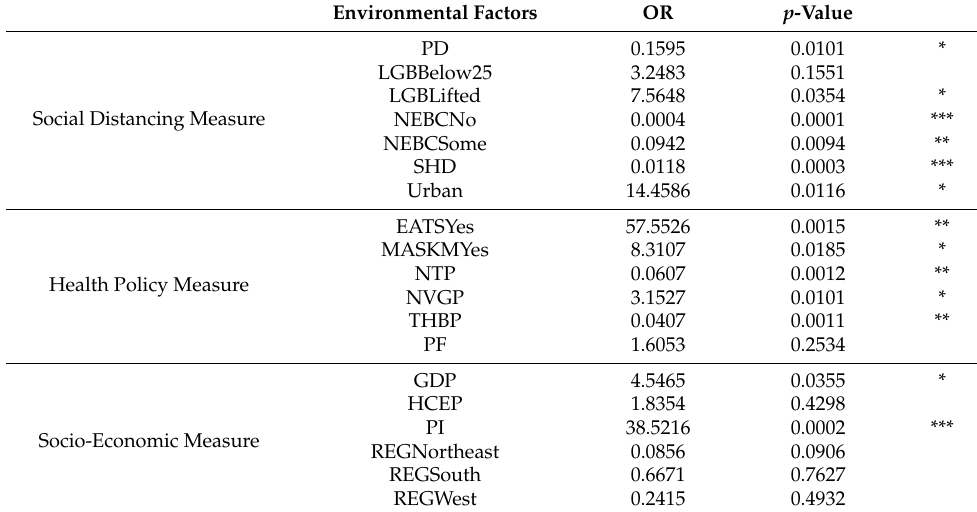
Table 7. The results of fitting a logistics regression model on